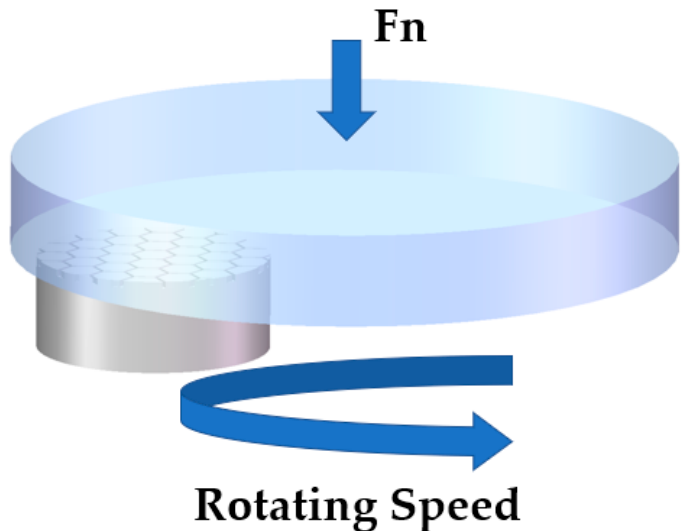
Figure 3. The schematic diagram of the frictional test equipment.